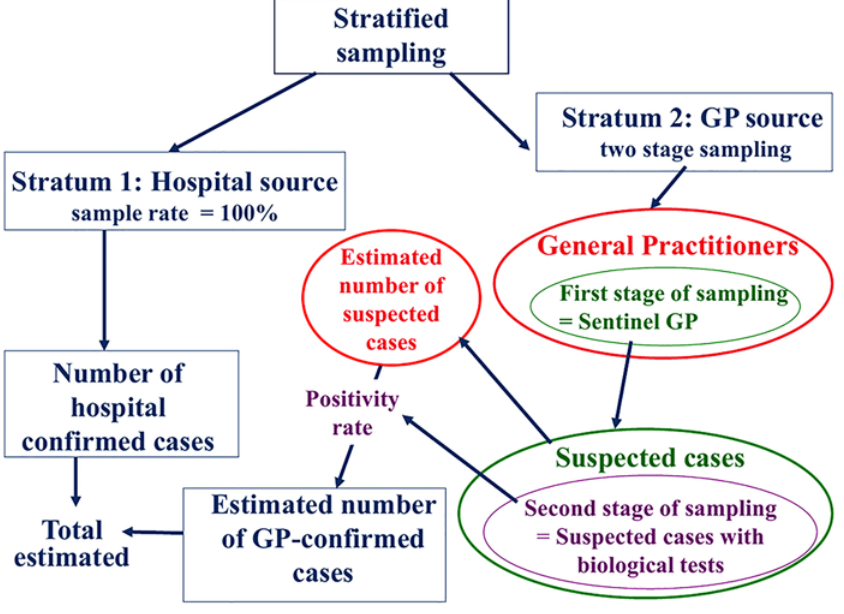
Fig 1. Epidemiological and statistical approach used to estimate global leptospirosis incidence, French West Indies, 2011.